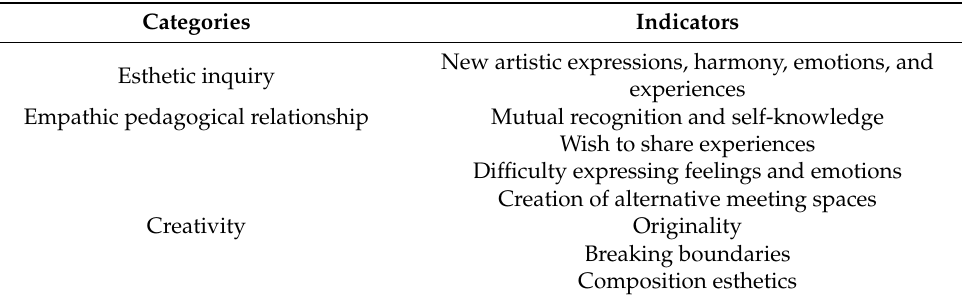
Table 1. Definition of the categories and indicators